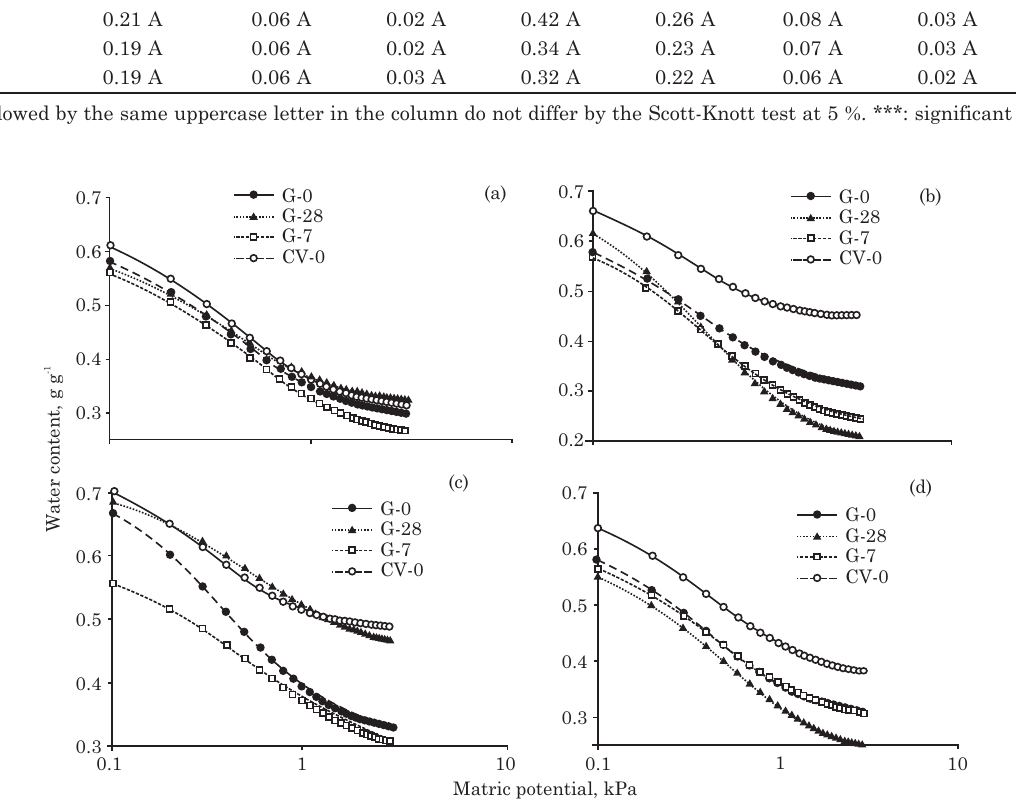
Figure 3. Water retention curves generated by the HEMC technique (M = f ( ΨΨΨΨΨ )): (a) fast wetting (0.05 m), (b) slow wetting (0.05 m), (c) fast wetting (0.20 m), and (d) slow wetting (0.20